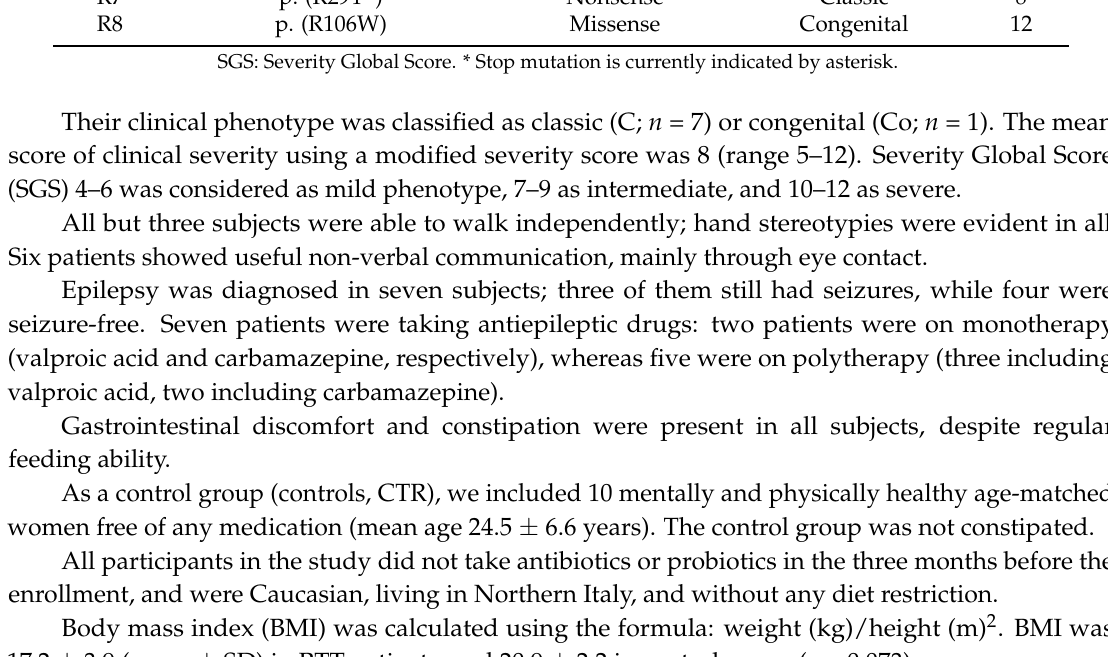
Table 1. Genetic defects and disease phenotypes of Rett syndrome (RTT) patients. Patient MECP2 Mutation Type of Mutation Disease Phenotype SGS R1 p. (R255 *) Nonsense Classic 12 p. (L383Pfs) Frame-shift Classic 7 c. (27 + 1_28 − 1)_(1461_?)del Intragenic deletion Classic 5 p. (R133C) Missense Classic 5 p. (R270Efs) Frame-shift Classic 10 R6 p. (R306C) Missense Classic 6 R7 p. (R294 *) Nonsense Classic 8 R8 p. (R106W) Missense Congenital 12 SGS: Severity Global Score. * Stop mutation is currently indicated by asterisk.